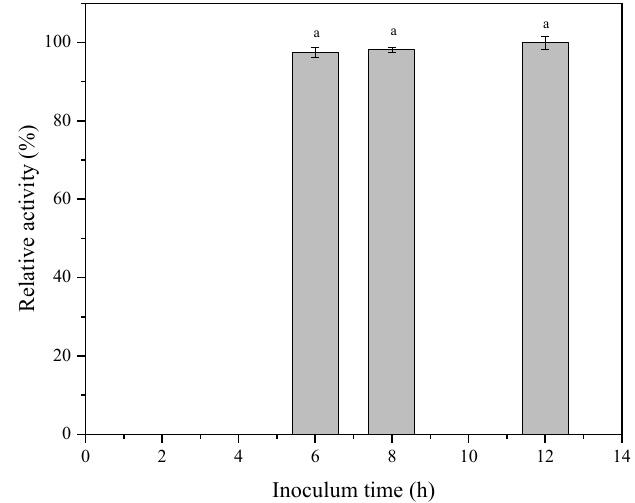
Figure 1. Effects of the inoculum age (6, 8, and 12 h) on ALDC activity from Bacillus subtilis ICA 56. Fermentation was conducted with an inoculation of 10% ( v / v ) in 250 mL at 37 ◦ C, 150 rpm, for 14 h. The Tukey test was performed to evaluate statistical differences, considering standard deviations and a p value < 0.05 as significant. The averages followed by the same letter do not differ statistically from each other by the Tukey test at 5%